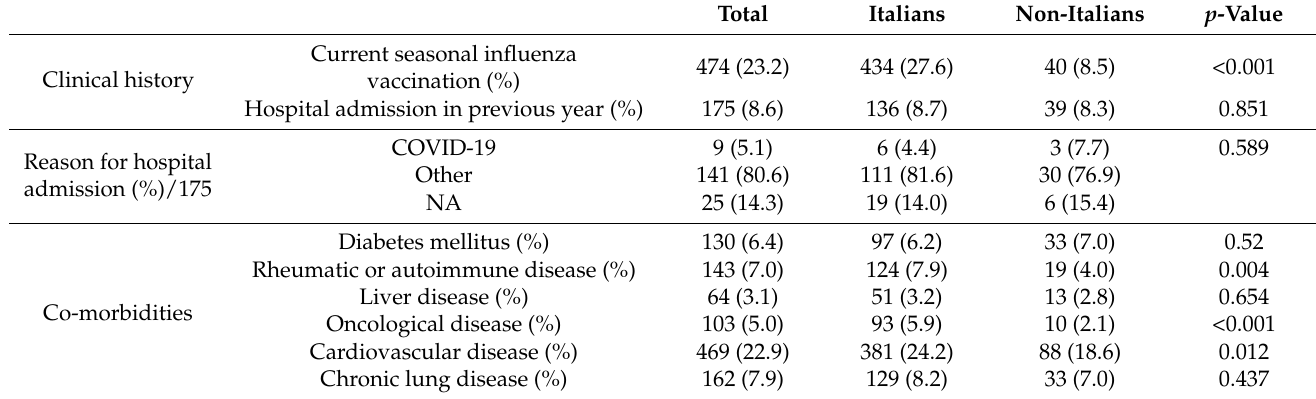
Table 3. Clinical characteristics of study